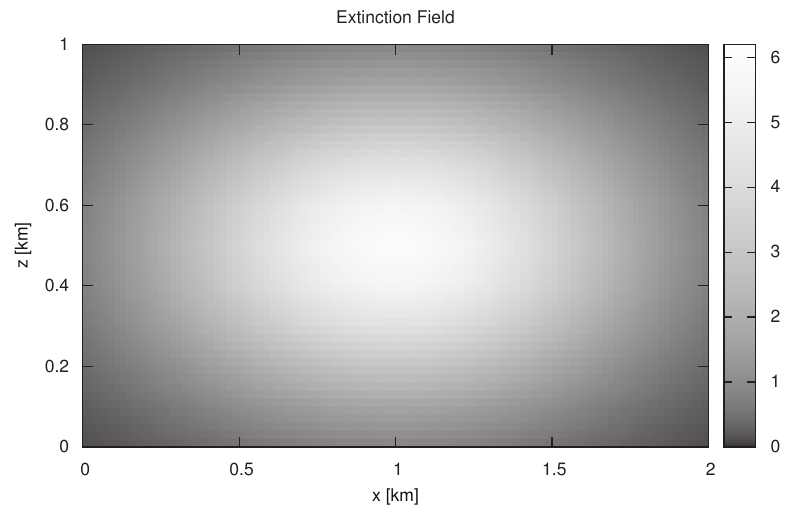
Figure 3. Extinction field in the plane y = L y